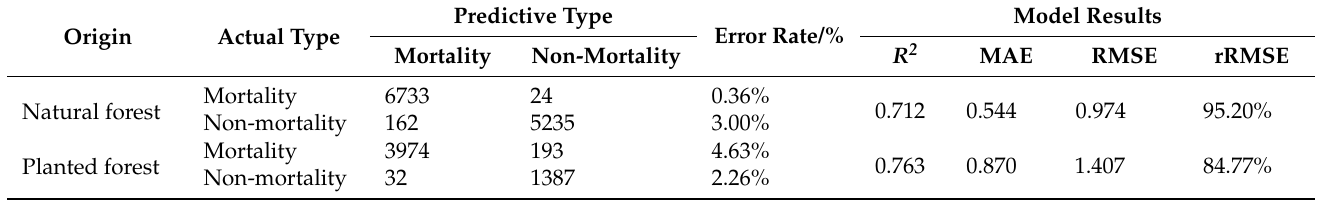
Table A6. Mortality model results in dominant tree species (group) in natural and planted forests.